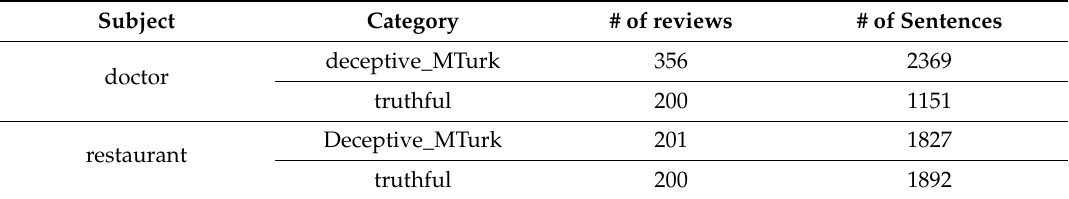
Table 6. The basic information about reviews in the deception